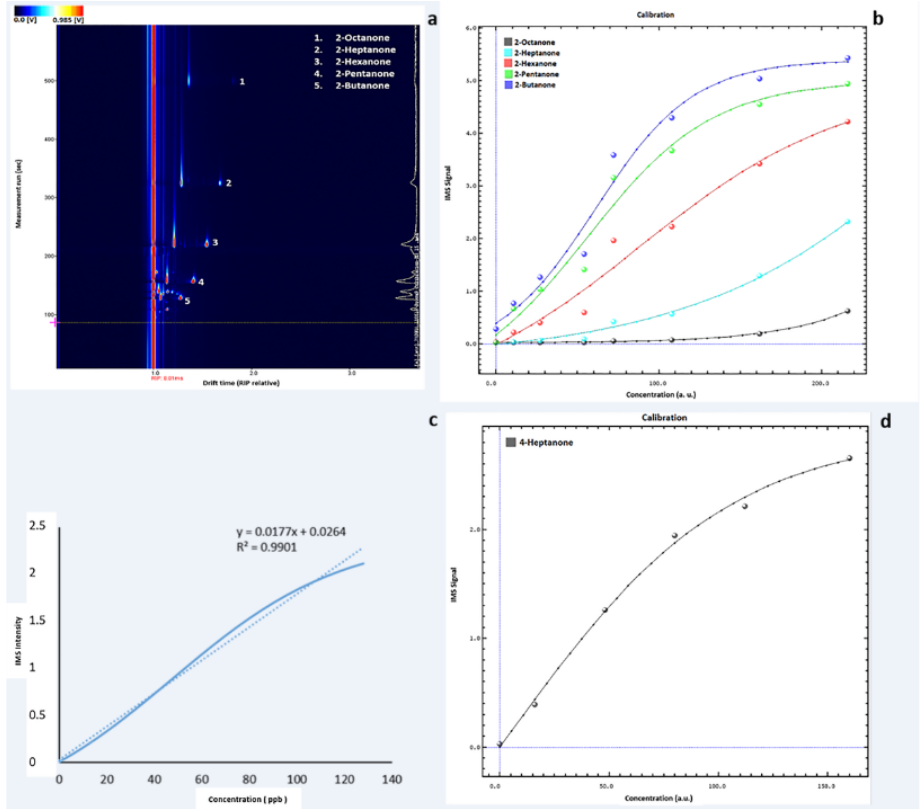
Figure 1. ( a ) Example of GC–IMS output of the ketone mix profile at the concentration of 108 ppb. The detected compounds have been highlighted. Each compound’s Dt has been normalised by means of the software application to the signal of the reaction ion peak (RIP). It represents the total number of ions available for ionisation, and therefore, it is used as the reference signal. The colour representation corresponds to a three-dimensional spectrum. An increasing concentration of VOCs is outlined by the colour change from blue to red. ( b ) Calibration curve obtained with the VOCal software by measuring the ketones mixture at seven different concentrations in the range of 218.4–10.8 ppb. Each colour corresponds to a detected compound in the ketone mix (blue = 2-butanone; green = 2-pentanone, red = 2-hexanone; light blue = 2-heptanone; black = 2-octanone). Dots represent the signal intensity for the concentrations analysed (expressed as arbitrary unit, a.u.); lines show the fit of the calibration curve. ( c ) Linearity range for 4-heptanone analysed by means of GC–IMS. The linearity curve and the regression line are reported for the concentration range of 0–128 ppb. ( d ) Calibration curve obtained with the VOCal software by measuring 4-heptanone at five different concentrations in the range of 0–160